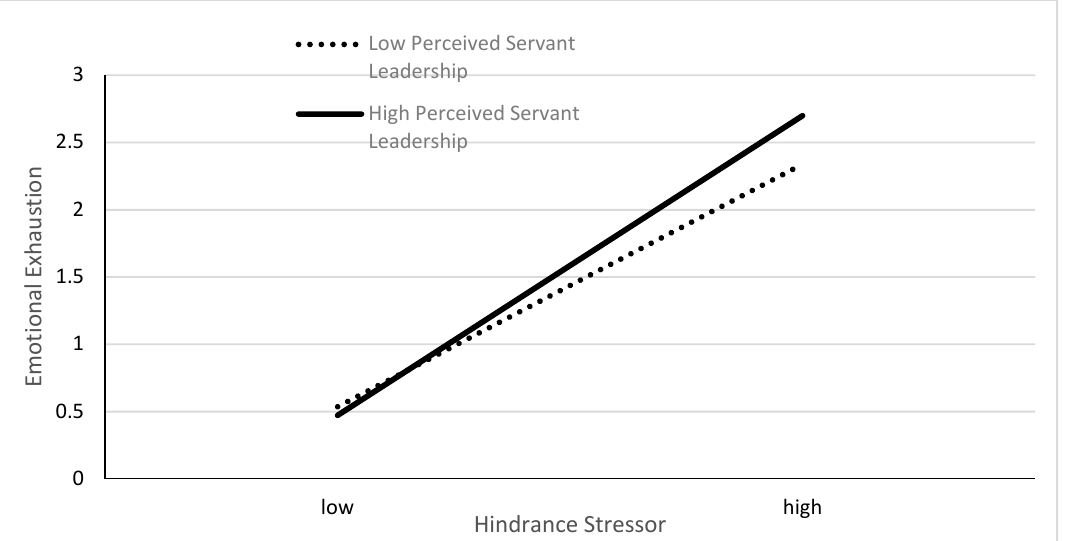
Figure 3. Moderating effect of perceived servant leadership on the relationship between challenge stressor and emotional exhaustion.